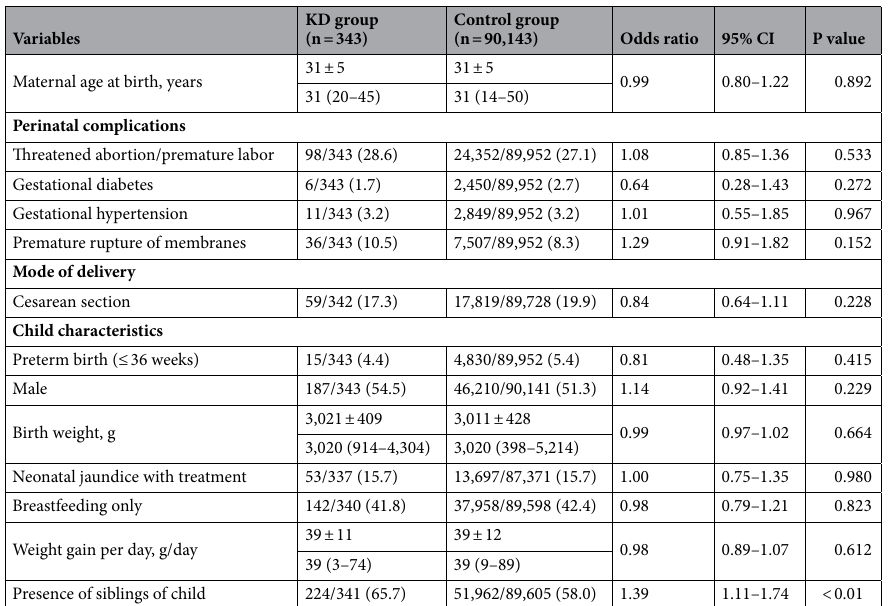
Table 3. Maternal perinatal backgrounds and child characteristics of the study population. Data are presented as n (%), mean ± standard deviation, or median (range). KD Kawasaki disease, 95% CI 95% confidence interval.